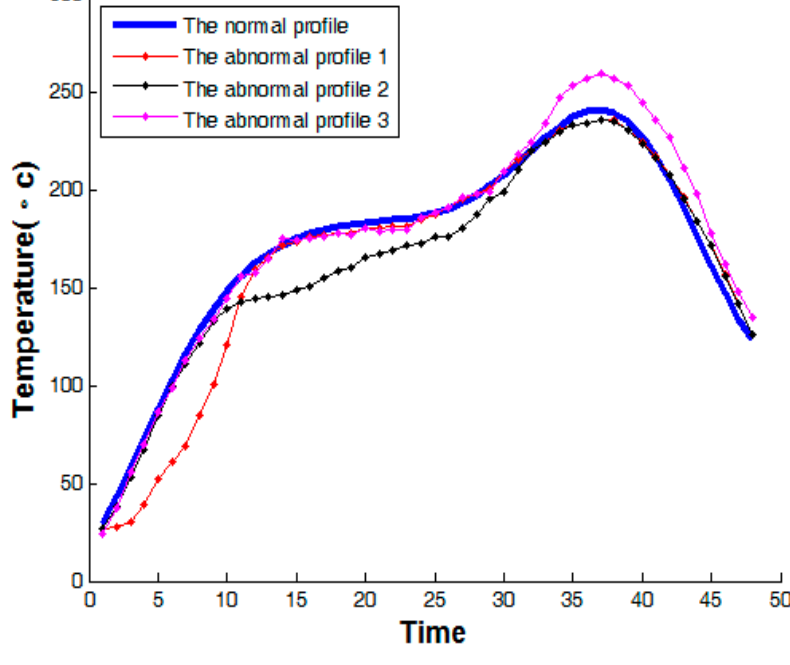
Figure 7. The simulations of abnormal profiles.